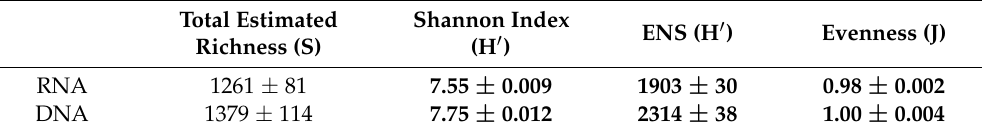
Table 2. Groundwater alpha diversity metrics of estimated total richness (S), Shannon index (H (cid:48) ), ef- fective number of species based on the Shannon index ENS (H (cid:48) ), and Pielou’s evenness (J). Significant differences are highlighted in bold. Values are means ±